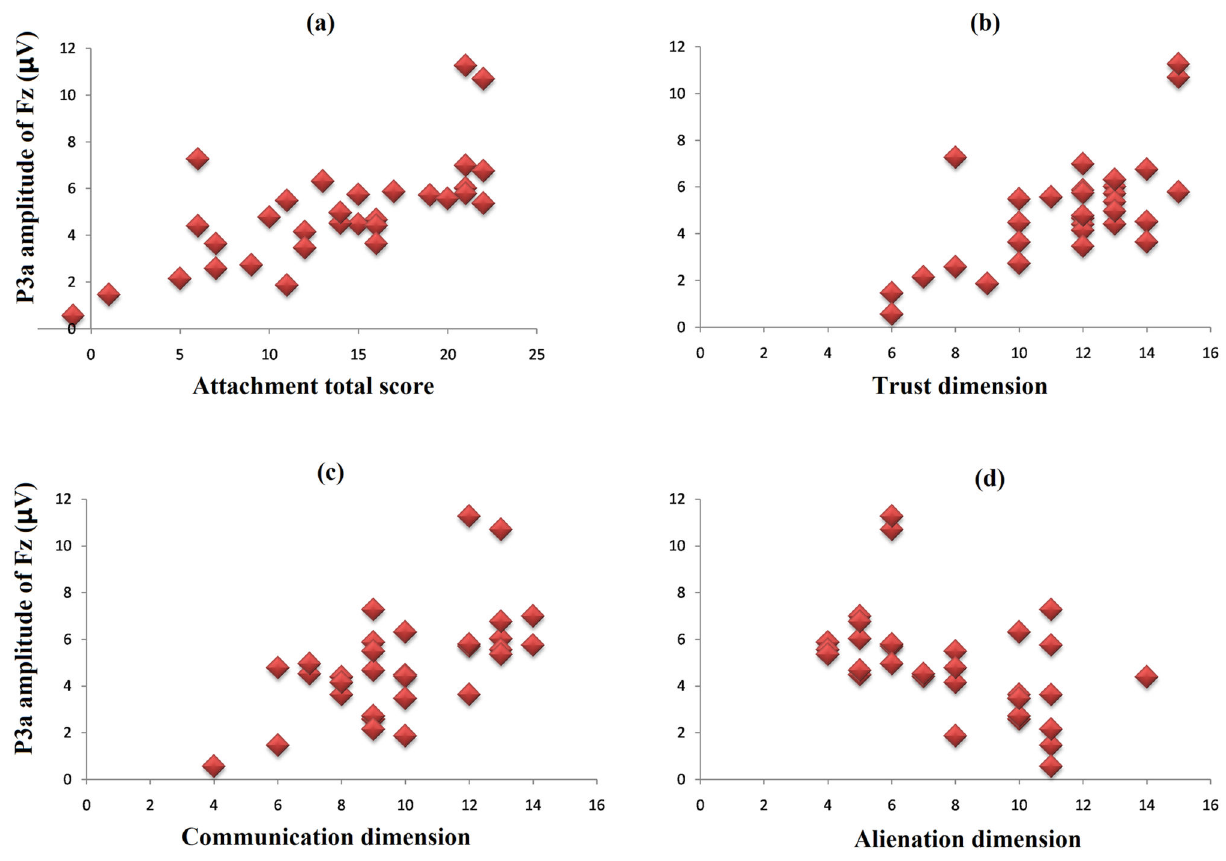
Figure 4. The correlations between the paternal attachment scores and P3a amplitudes evoked by a father’s face. The figure shows that the P3a amplitude was positively correlated to the total attachment score ( r = .71, p < .001, Figure 4a), the trust dimension ( r = .68, p < .001, Figure 4b) and the communication dimension ( r = .60, p < .001, Figure 4c) and negatively correlated with the alienation dimension ( r = -.50, p < .005, Figure 4d). doi: